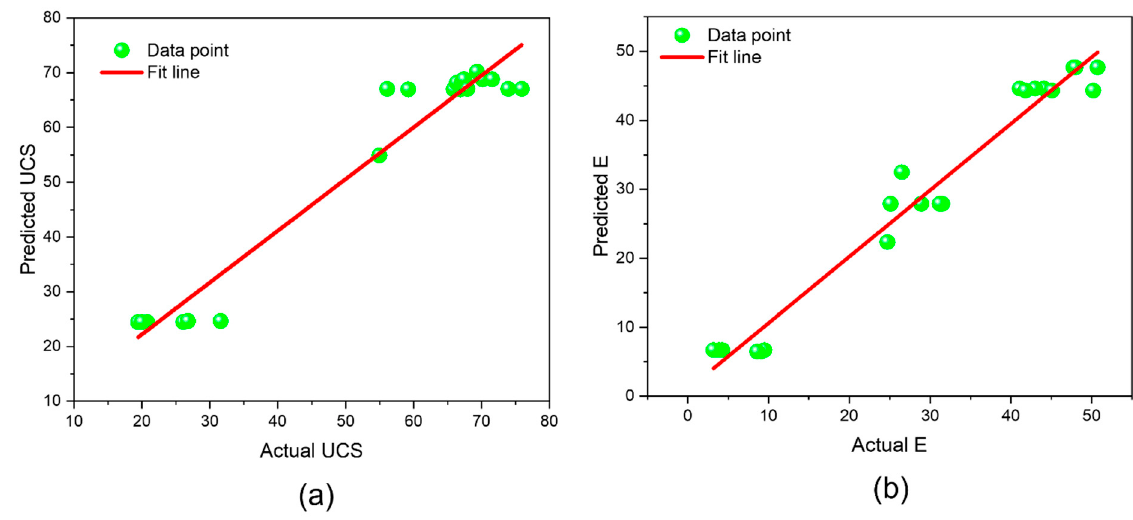
Figure 9. Relationship between expected and real UCS ( a ) and E ( b ) based on the KNN approach.